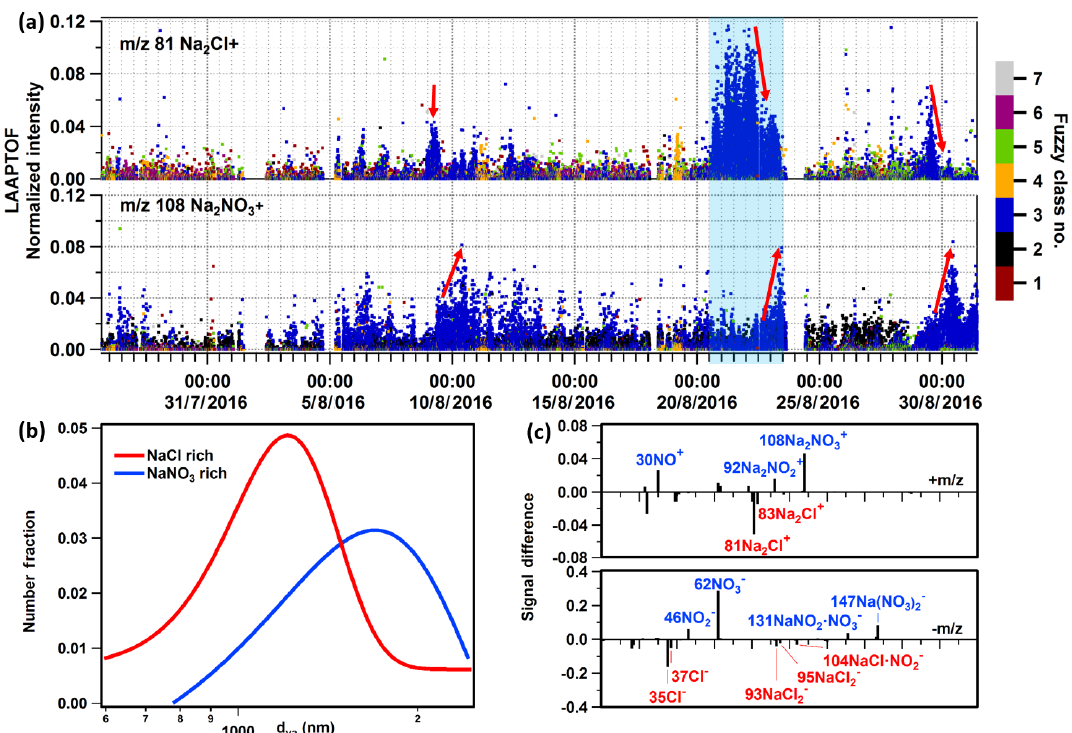
Figure 6. (a) Time series of sodium chloride and nitrate signatures in seven particle classes. The y axis is the normalized ion intensity (each ion peak intensity is normalized to the sum of all ion signals; positive and negative ions were analysed separately). The seven classes are as follows. Class 1: calcium–soil; class 2: aged soot; class 3: sodium salts; class 4: secondary inorganics–amine; class 5: biomass burning–soil; class 6: biomass burning organosulfate; and class 7: mixed/aged dust. Obvious sodium chloride and nitrate signatures are mainly found in class 3 labelled in blue. (b) Size distributions of NaCl-rich (young sea salt) and NaNO 3 -rich (aged sea salt) particles. Gaussian fit NaCl d va ( ± σ) = 1211 ( ± 352 ) nm; NaNO 3 1697 ( ± 946 ) nm. (c) Spectra difference between aged and young sea salt particles (aged – young). The blue band marks the sodium-chloride-rich